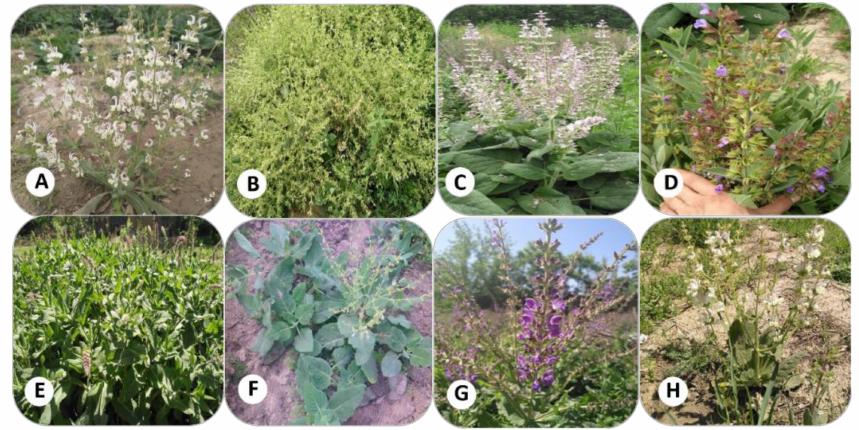
Figure 1. Salvia species cultivated in farm conditions. ( A ), S. atropatana ; ( B ), S. macrosiphon ; ( C ), S. sclarea ; ( D ), S. officinalis ; ( E ), S. nemorosa ; ( F ), S. syriaca ; ( G ), S. virgata ; ( H ), S. frigida